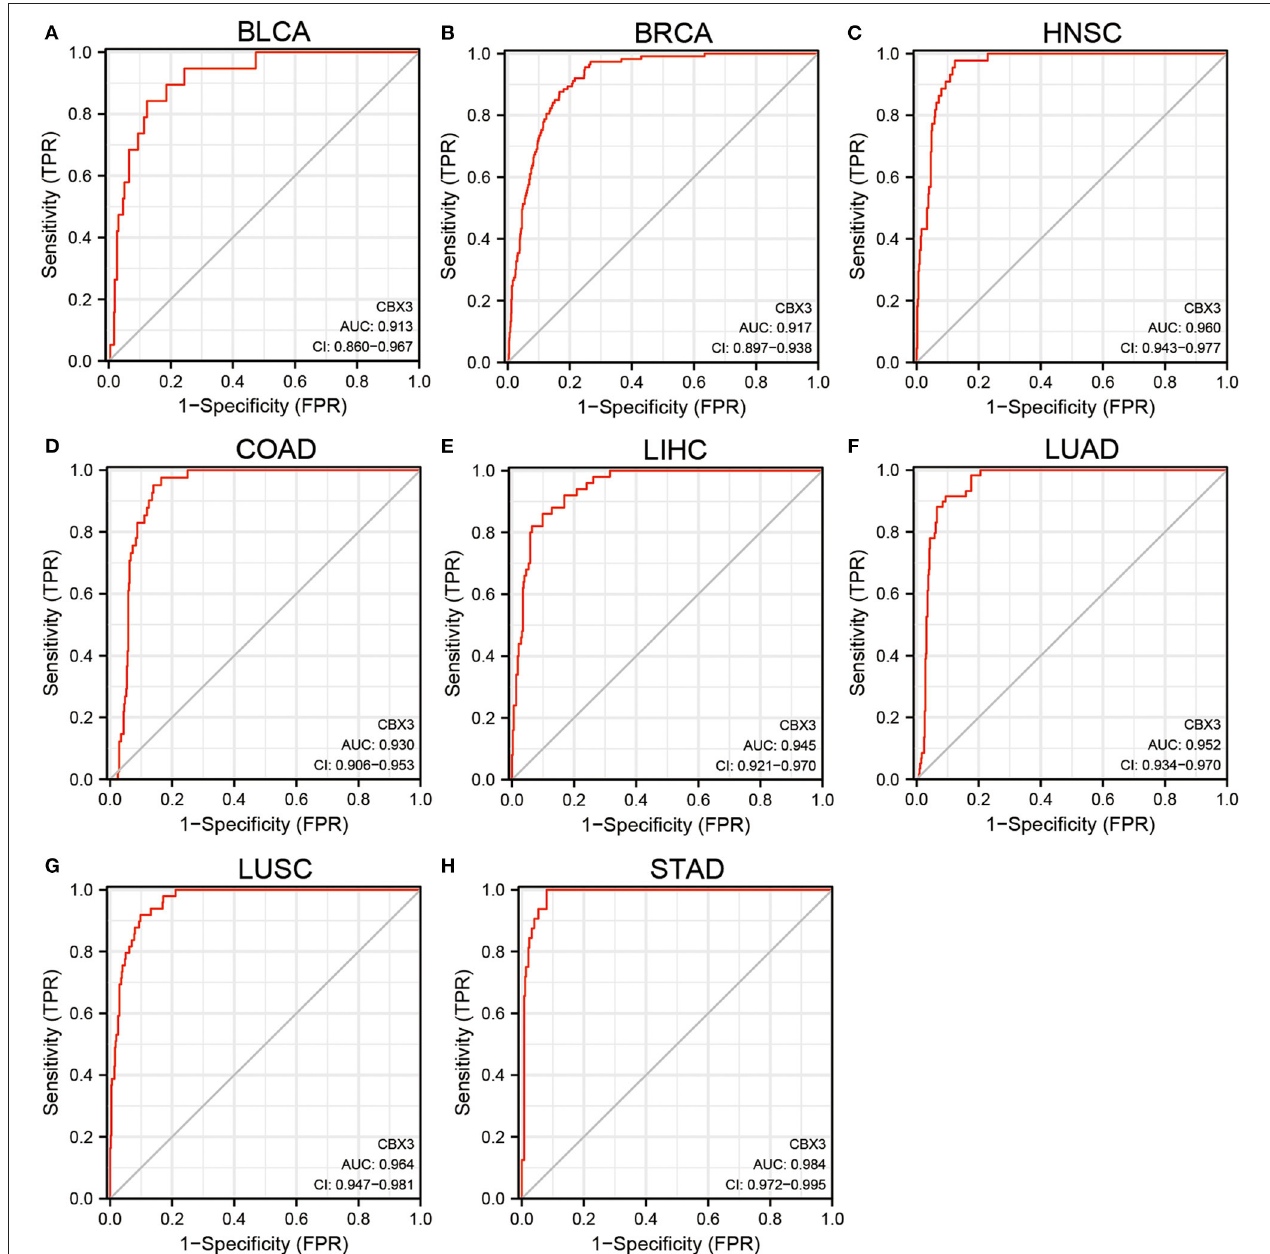
FIGURE 2 | (A–H) Comparison of CBX3 expression between tumor and paired non-tumor normal samples. ROC analysis of CBX3 illustrated auspicious capability to differentiate tumors from non-tumor normal